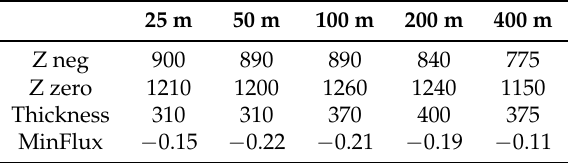
Table 4. The entrainment zone thickness at different grid lengths for the CBL2 simulations, based on the height “Z neg” where the total flux first becomes negative and “Z zero”, above which it is zero. Listed also is the minimum temperature flux, normalized by Q ∗ .